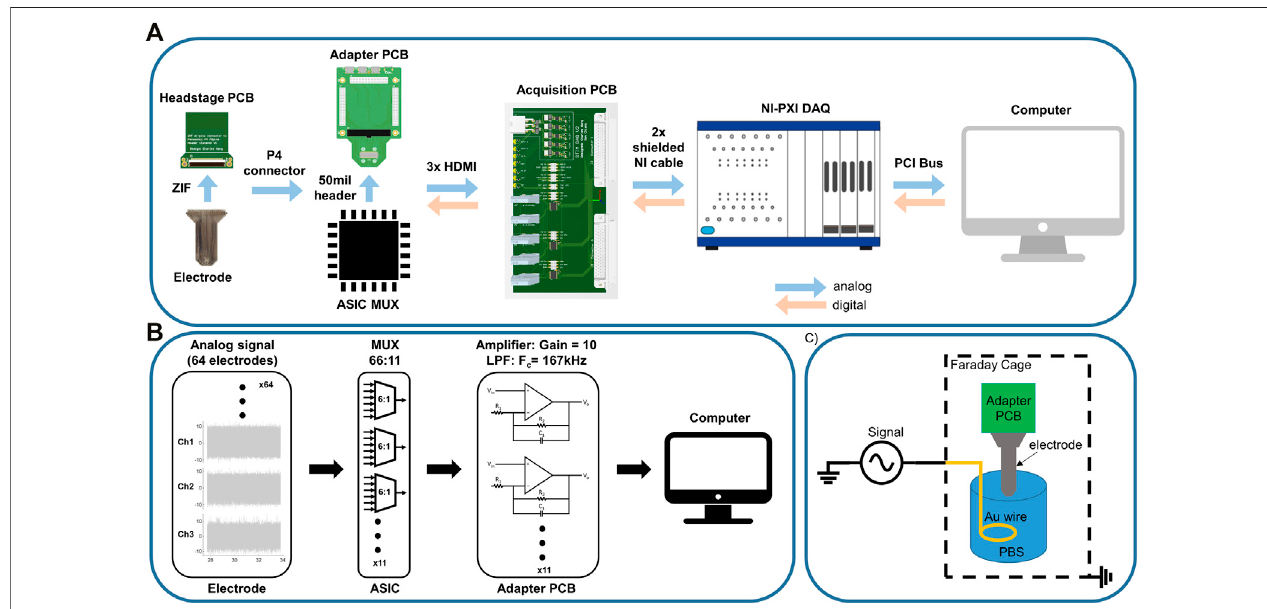
FIGURE3| Recordingsetup. (A) Analogrecordingsetup:ElectrodearrayusedaZIFconnectortoattachtotheheadstagePCB.HeadstagePCBconnectedtothe adapter PCB via P4 connector. The adapter PCB passed signals to the ASIC MUX via 50mil pin connectors and relayed the signal to the acquisition PCB through 3 x µHDMIcables.TheacquisitionPCBpassedthesignaltotheNIDAQ,wheretheADCsampledthesignalandparseditinto61channelsat950SPSperelectrodechannel. TheNIalsosentdigitalsignals(clock,switching)totheASICMUX. (B) Signalprocessingpipe-line:Analogsignalssensedattheelectrodesweremultiplexedonthe ASIC MUX and low-pass fi ltered (F c = 167 kHz) and ampli fi ed (Gain = 10) on the adapter PCB (non-inverting lowpass fi lter con fi guration). Filtered signals were then passed to the ADC to be parsed back into 61 channels and decimated (middle four of every 8) and averaged to avoid edge effects of switching. (C) Noise and